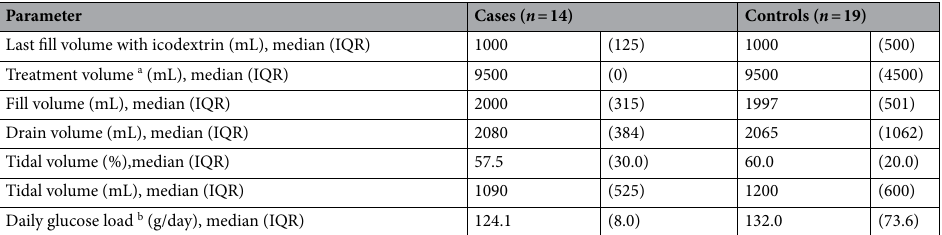
Table 2. APD treatment parameters. All patients performed tidal PD and received icodextrin-containing PD fluid for the daytime dwell, except for one patient in the control group who performed nightly intermittent PD without last fill. For all parameters, P values > 0.05 when comparing cases vs controls (two-tailed MWU test), except for daily glucose load ( P = 0.0471). a Last fill with icodextrin excluded. b Daily glucose load was calculated as the total glucose in the fresh PD fluid infused each day in